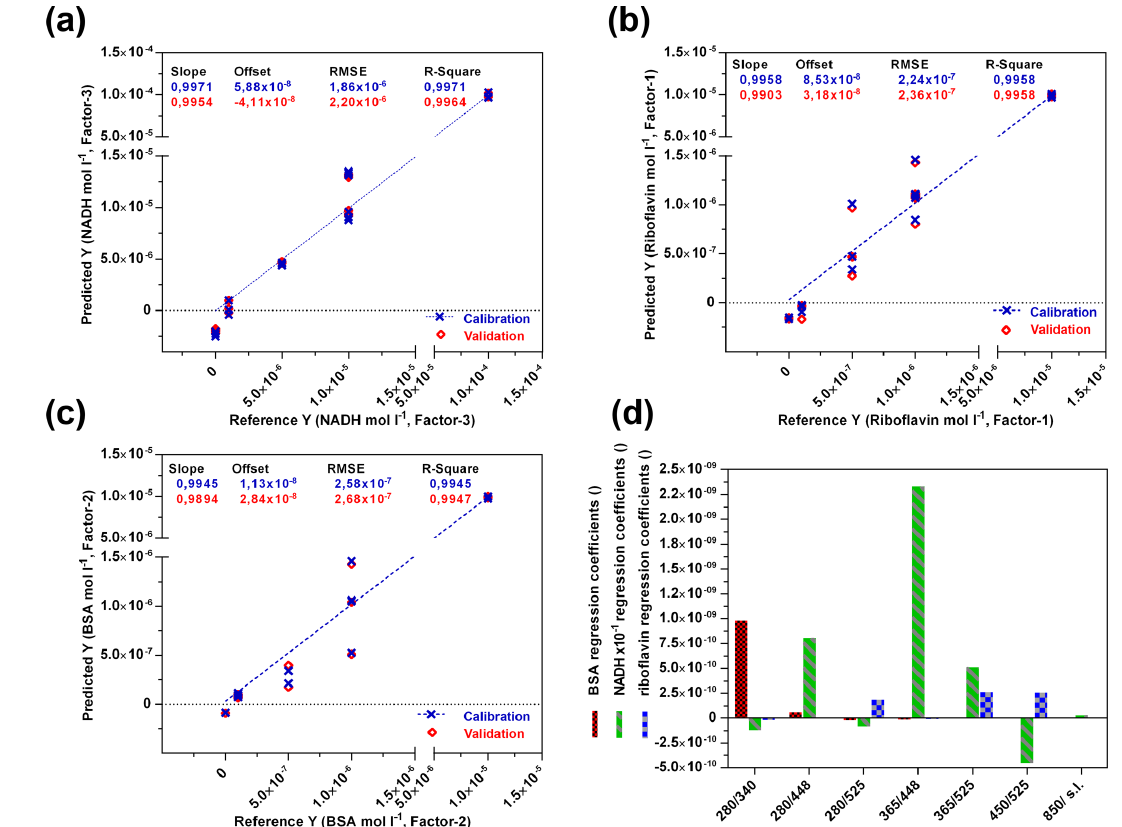
Figure 3. Selectivity test of the sensor based on different mixtures of three fluorophores (BSA, NADH and riboflavin). PLS models of (a) BSA, (b) riboflavin and (c) NADH. (d) Regression coefficients of the three PLS